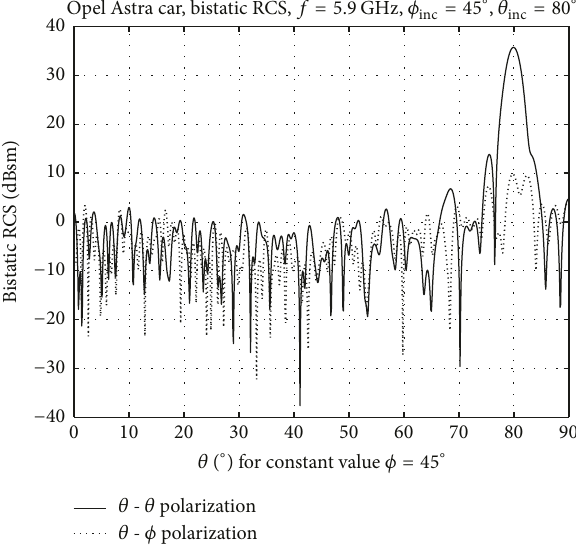
Figure 5: Convergence analysis for the PLACYL case, 𝑓 = 20 GHz.